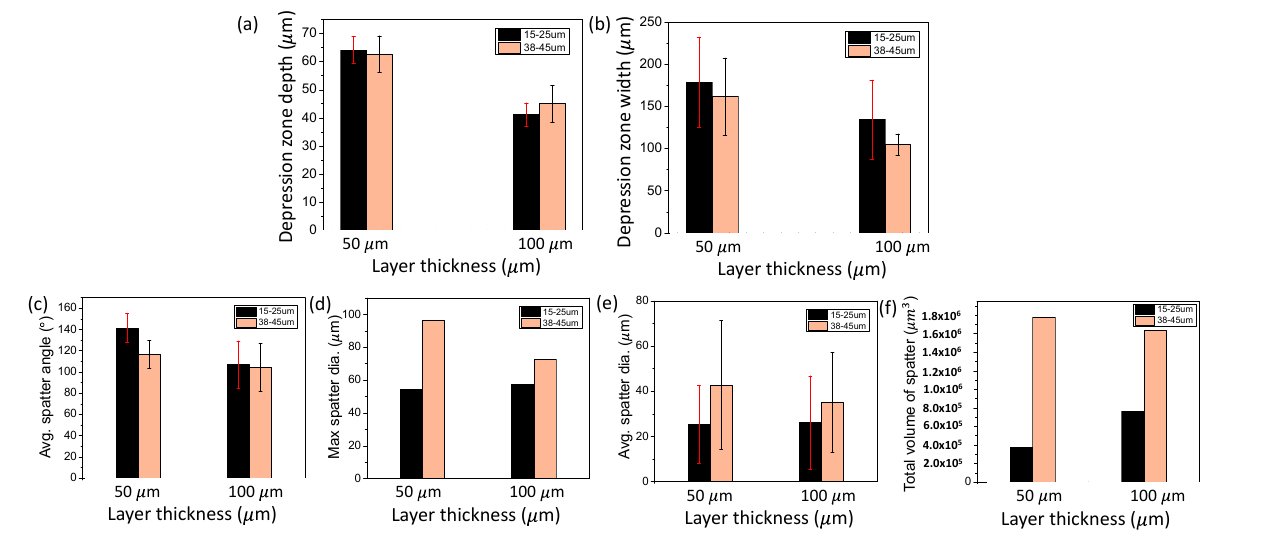
Figure 8. Effects of layer thickness variation on SLM dynamics. ( a , b ) Changes in the depression zone depth and width due to variation in the layer thickness. ( c – f ) Changes in the spatter average direction, maximum diameter, average diameter, and total volume due to variation in the layer thickness. Testing is conducted using 15–25 µ m and 38–45 µ m, plasma atomized Ti6Al4V powders.